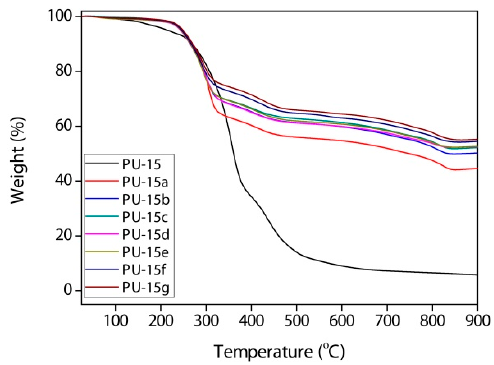
Figure 14. TGA analysis of pure PU NCs (PU-15) and MNPs-IL-C 4 @PU NCs (1%–11%).